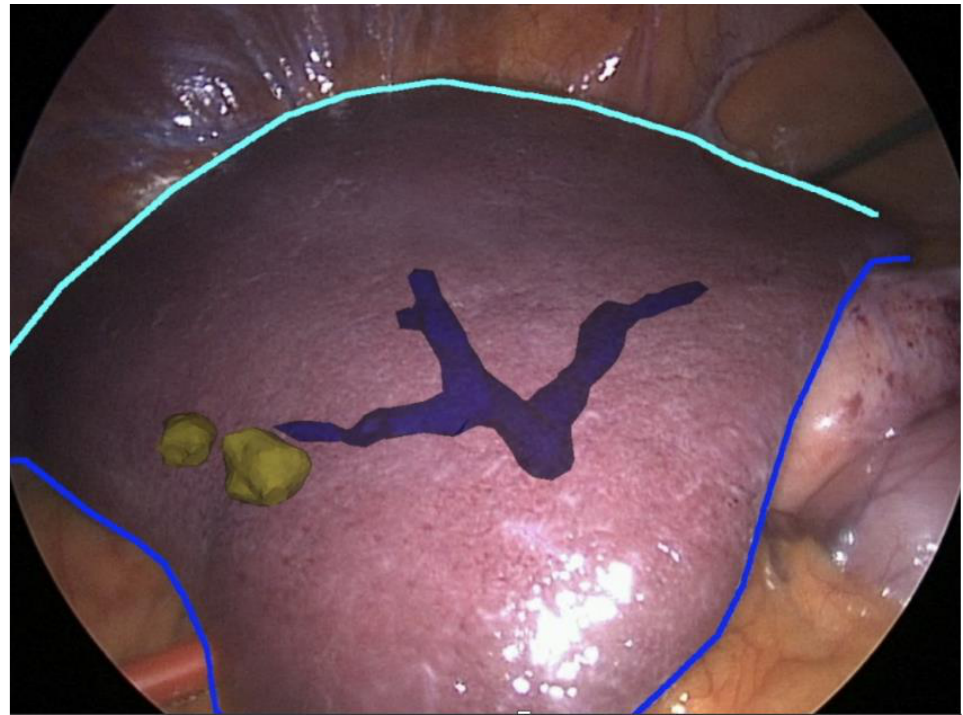
Figure 9. Augmented reality (AR) for partial hepatectomy. Intra-hectic portal vein (blue) and hepatic tumors (yellow) (EnCoV, SurgAR, Clermont-Ferrand, France).